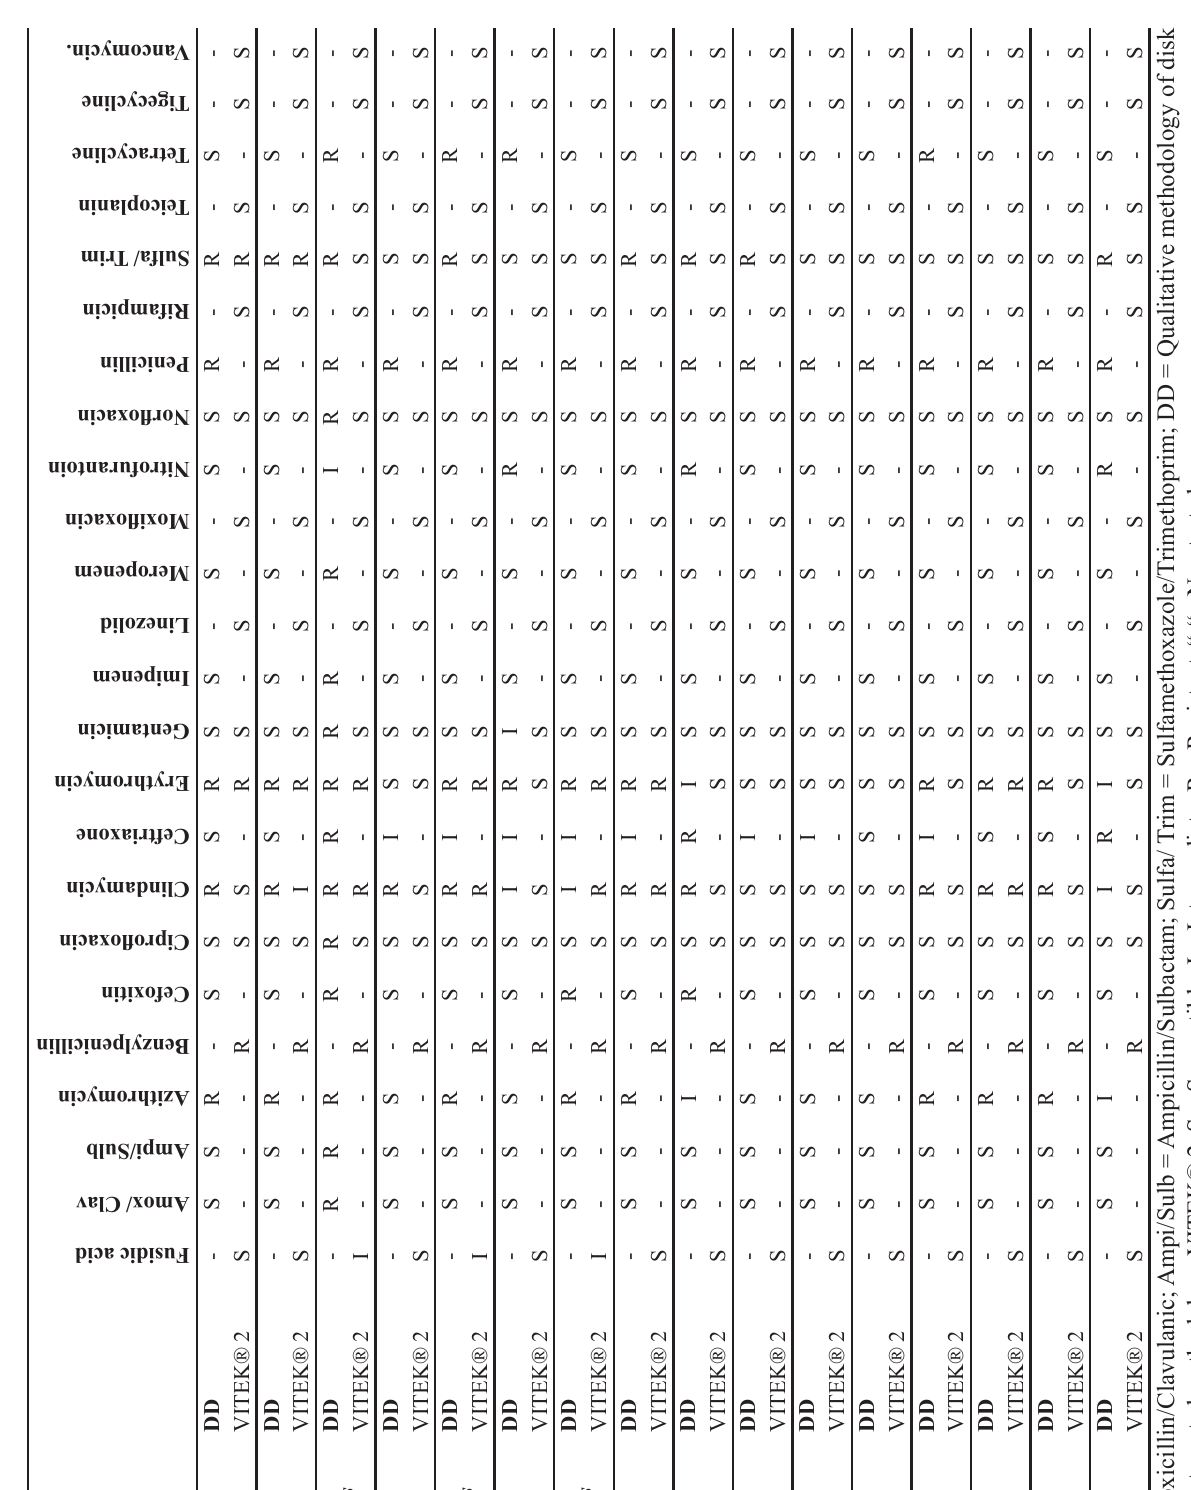
u s ti c h y op ap r s S .